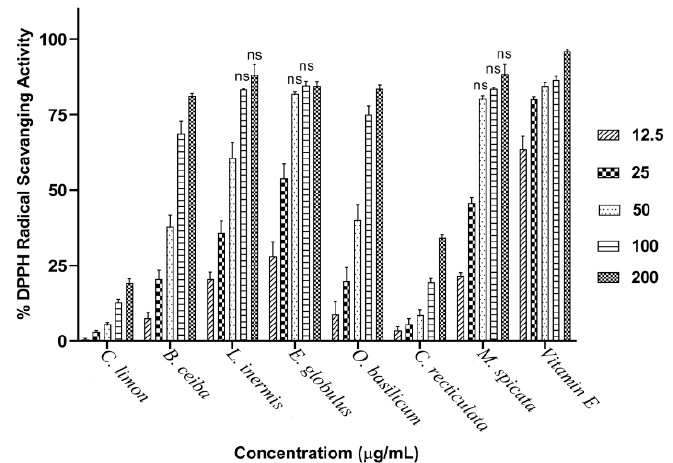
Figure 4. DPPH radical scavenging activity of plant extracts. The ability of plant extracts across a concentration range of 12.5–200 µg/mL to scavenge the DPPH • was assessed spectrophotometrically and compared with Vitamin E. Histograms represent means ± SEM for an n-number of 4; ns = nonsignificant differences from Vitamin E.